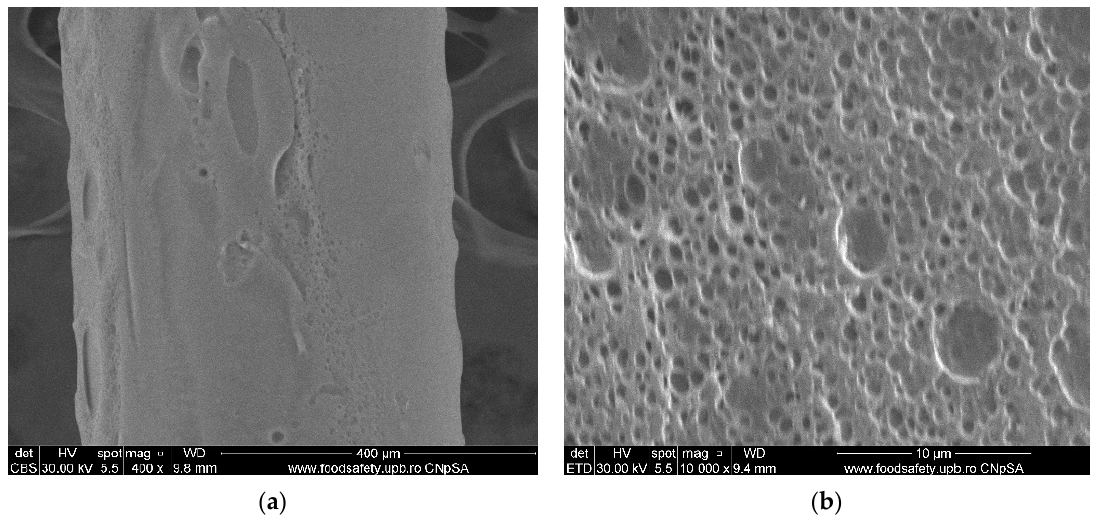
Figure 10. Morphology MHEC–PPM membrane: ( a ) membrane cross–section; ( b ) membrane surface.